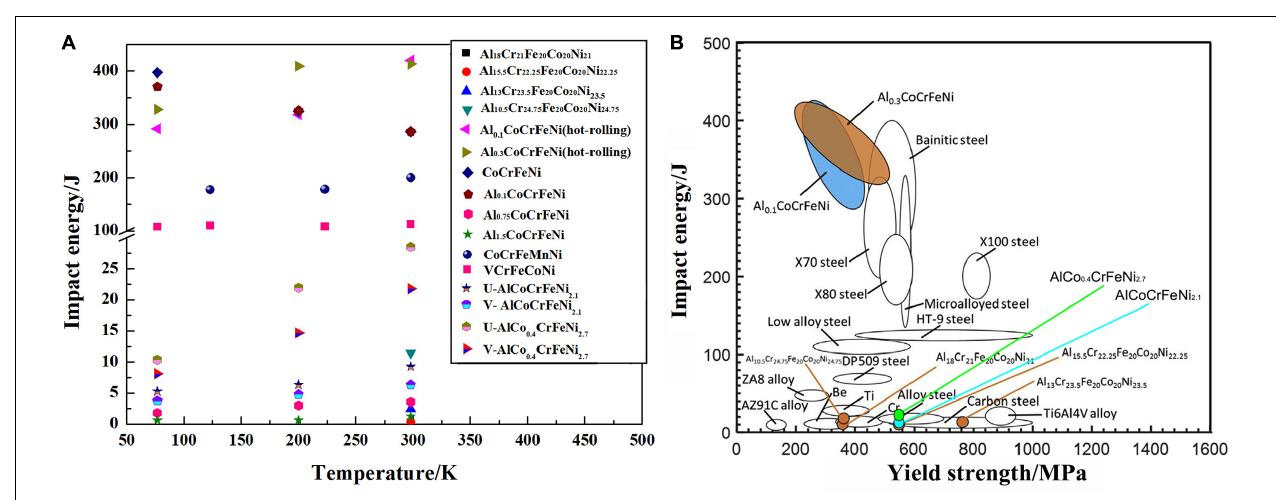
FIGURE 8 | Summary of the impact energy of the materials. (A) Impact energies of the AlCo x CrFeNi 3 . 1 − x alloys and other HEAs at the different temperatures (Chen et al., 2016; Li and Zhang, 2016; Kim et al., 2018; Xia et al., 2018; Jo et al., 2019); (B) impact energy-yield strength diagram for selected HEAs and some typical materials (Li et al.,